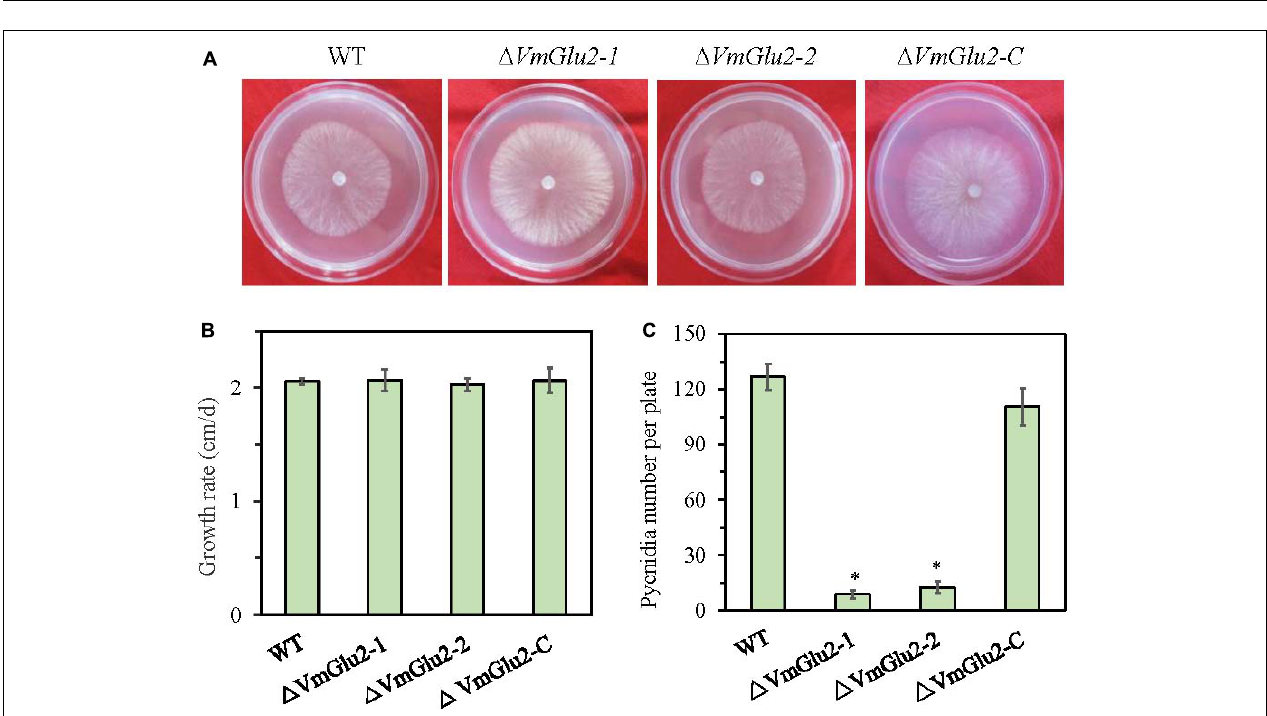
FIGURE 4 | Colony morphology, growth and development of the wild-type stain (WT), VmGlu2 deletion mutants ( (cid:49) VmGlu2 ) and complementary strain ( (cid:49) VmGlu2-C ). (A) The colony phenotype of different strains growing on PDA at 25 ◦ in the dark for 2 days. (B) The mycelia growth rate of different strains on PDA at 25 ◦ for 3 days. (C) Number of pycnidia produced on per 9.0 cm petri plate under UV-light (365 nm) at 25 ◦ . Bars indicate standard deviation of means of four replicates. Asterisks represent significant differences ( P < 0.05) in the gene deletion mutants as compared to that in the WT.